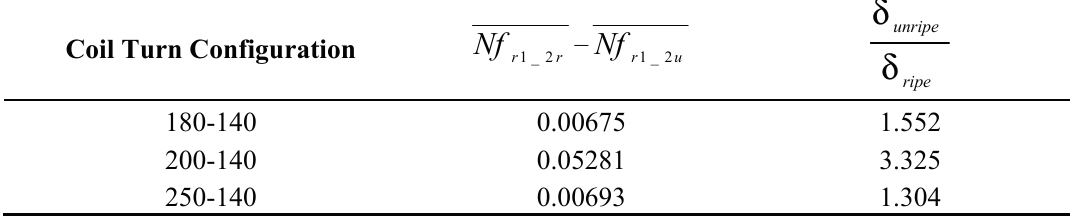
Table 9. Differences between first peak and second